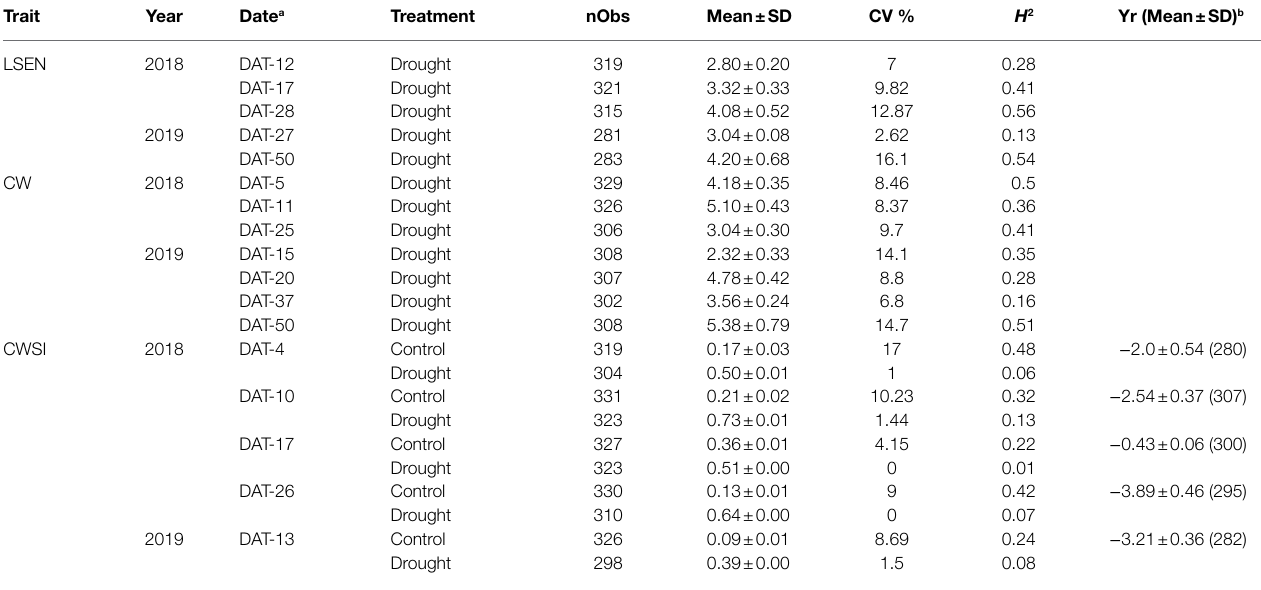
TABLE 3 | Summary statistics of BLUP values from control and drought fields in 2018 and 2019.